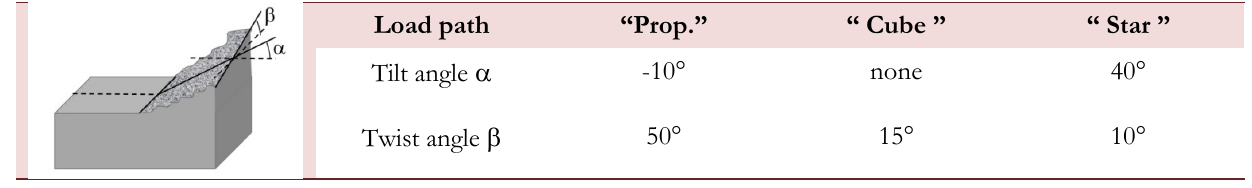
Table 2: Twist angle (  ) through the thickness of the specimen (5 mm) and tilt angle (  ) after the crack has propagated in mixed mode by  a=2mm. Effect of the load path on the crack path, after the crack has propagated in mixed mode I+II+III from 2a=34mm up to